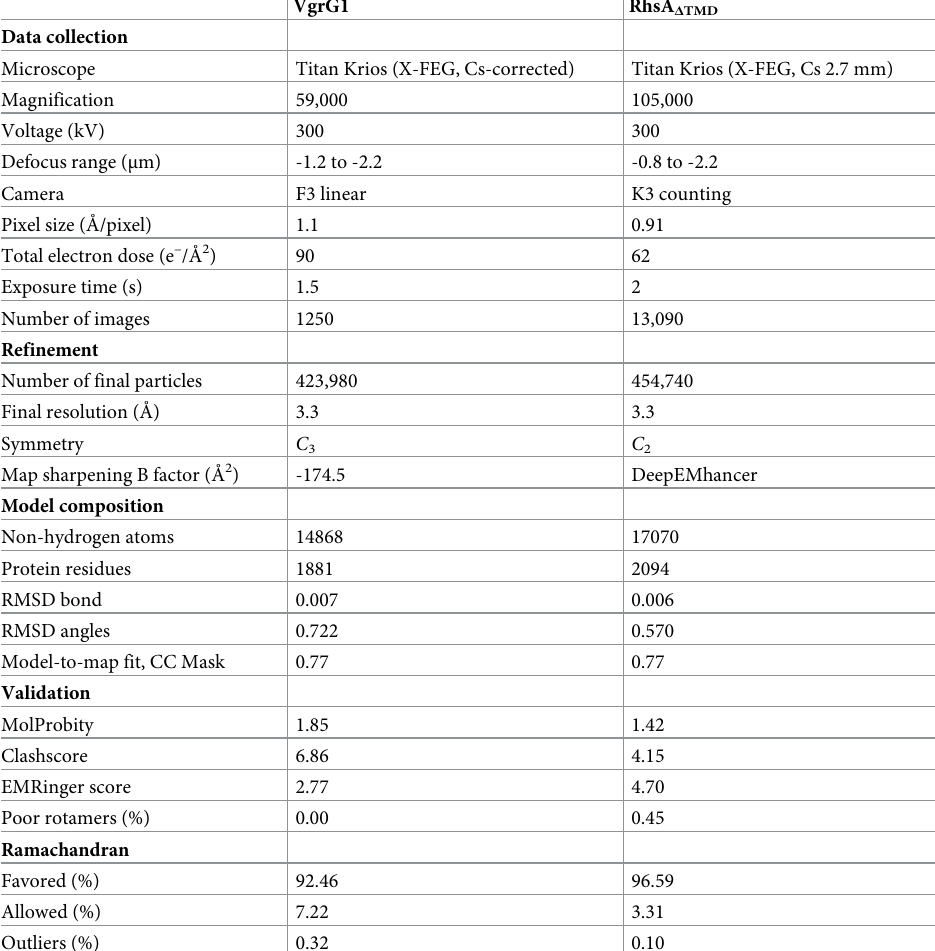
Table 1. Statistics of cryo-EM data collection, image processing and model validation. VgrG1 RhsA Δ